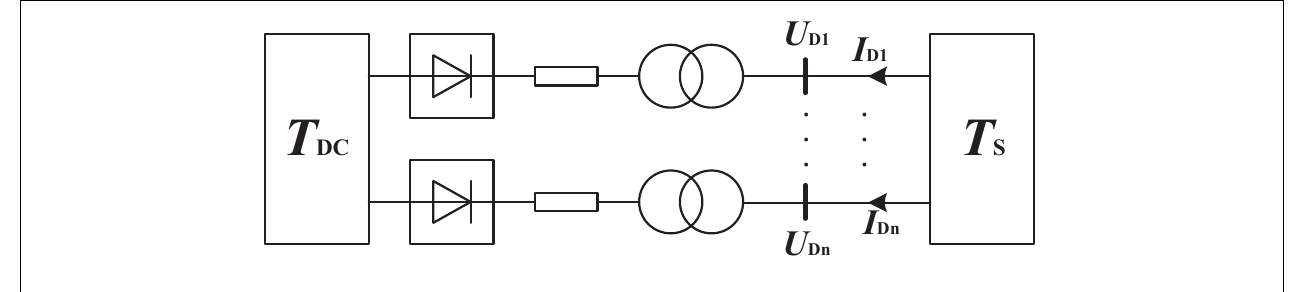
FIGURE 1 | Common scheme of the hybrid simulation.